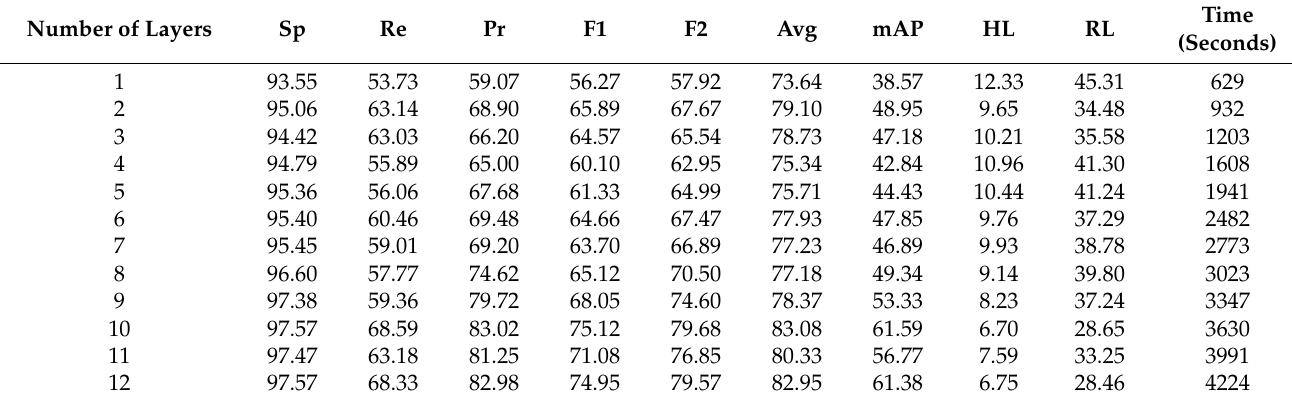
Table 4. Results of the Trento multi-label